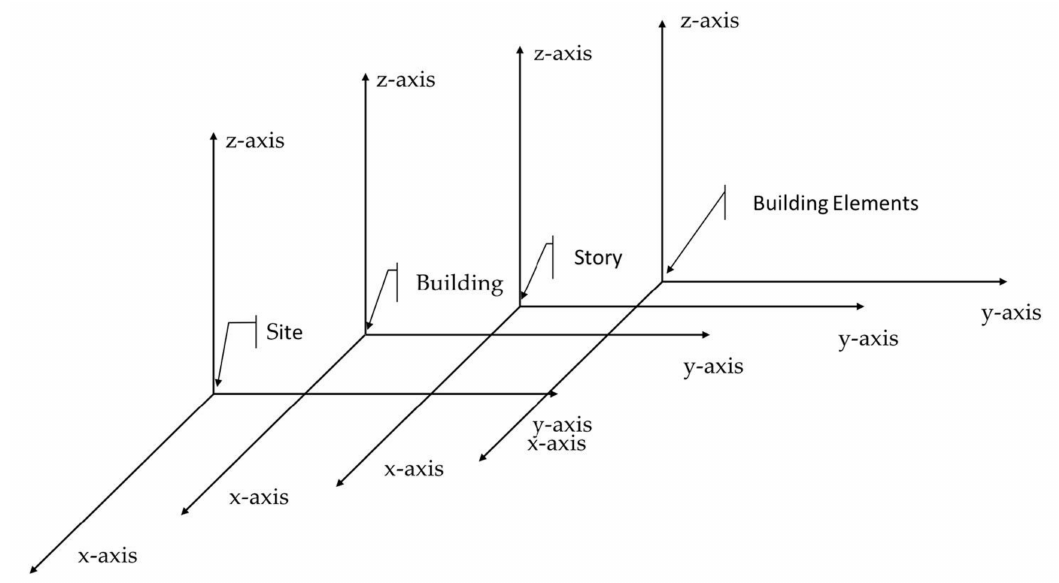
Figure 6. IFC local coordinate system, adapted from Lee and Kim